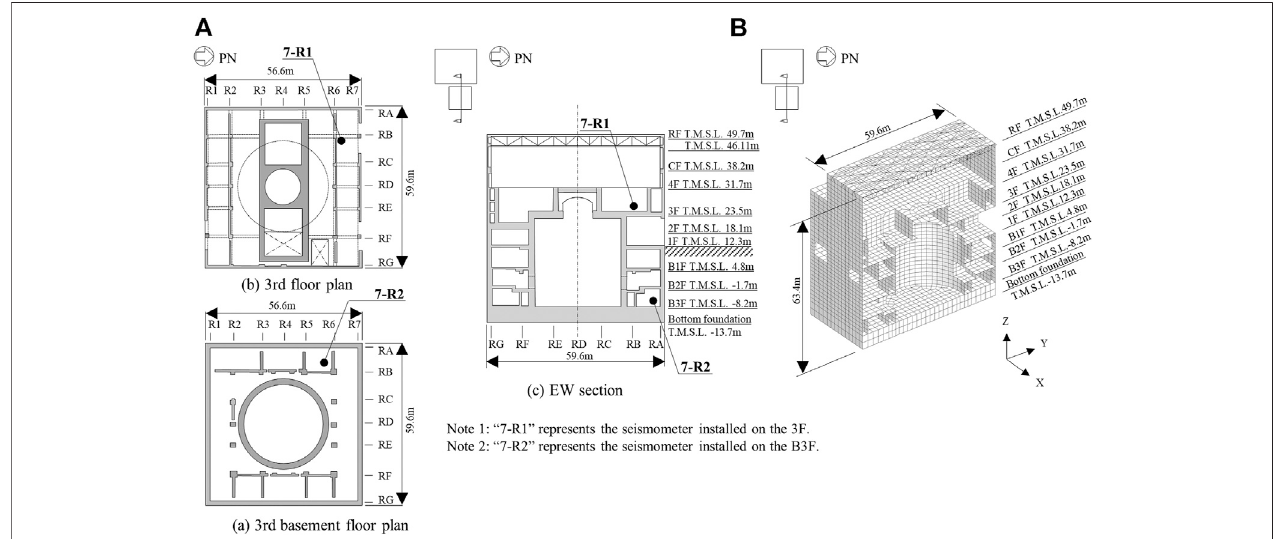
FIGURE 3 | Depiction of structural model. (A) Key plans and key cross section of the building. (B) Detailed structural model.